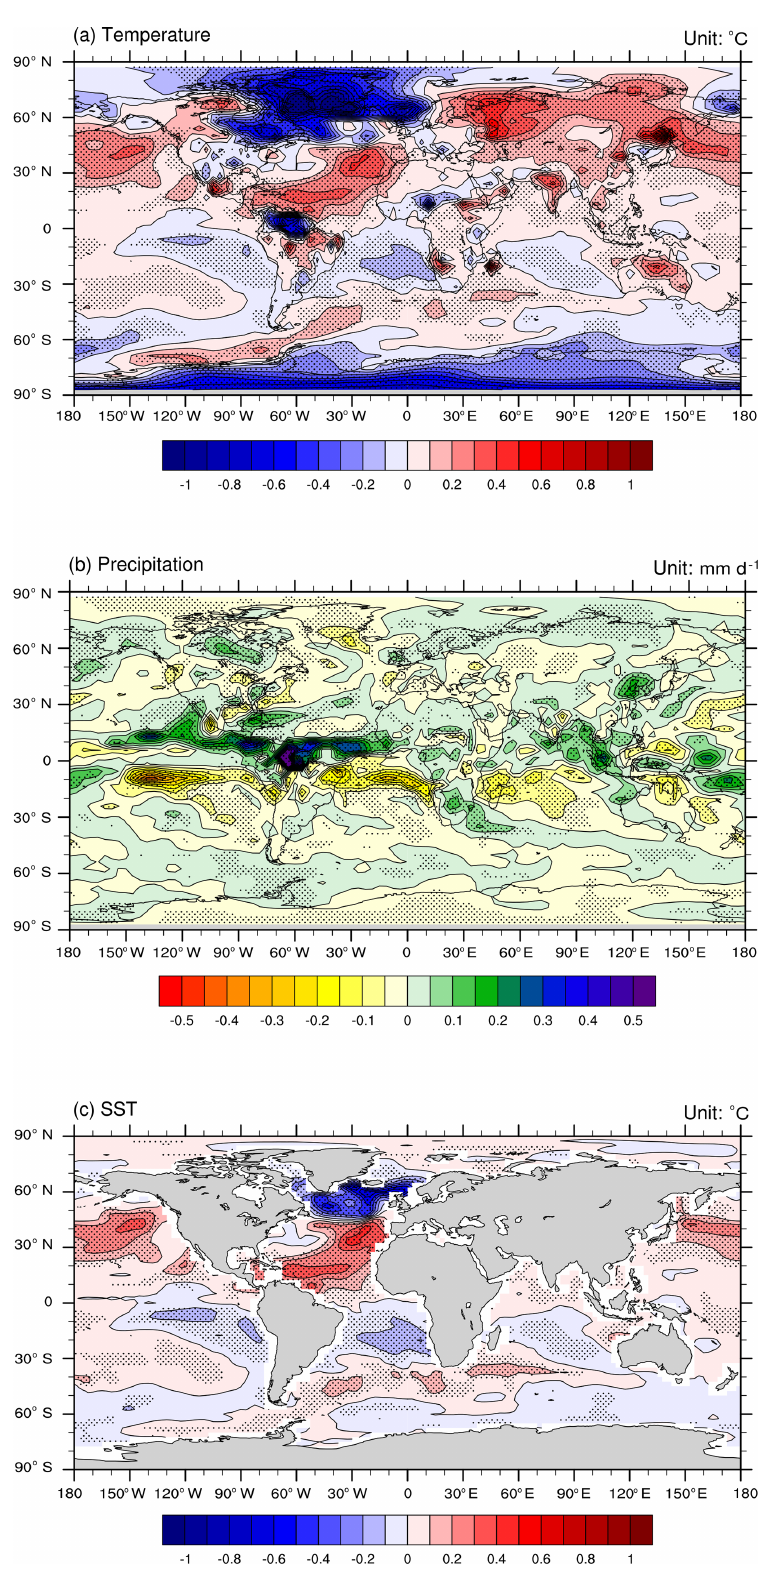
Figure 6. The differences between changes of (a) surface temperature ( ◦ C), (b) precipitation (mmday − 1 ), and (c) SST ( ◦ C) of the 5th millenniumBP and 9th millenniumBP periods shown in Figs. 2 and